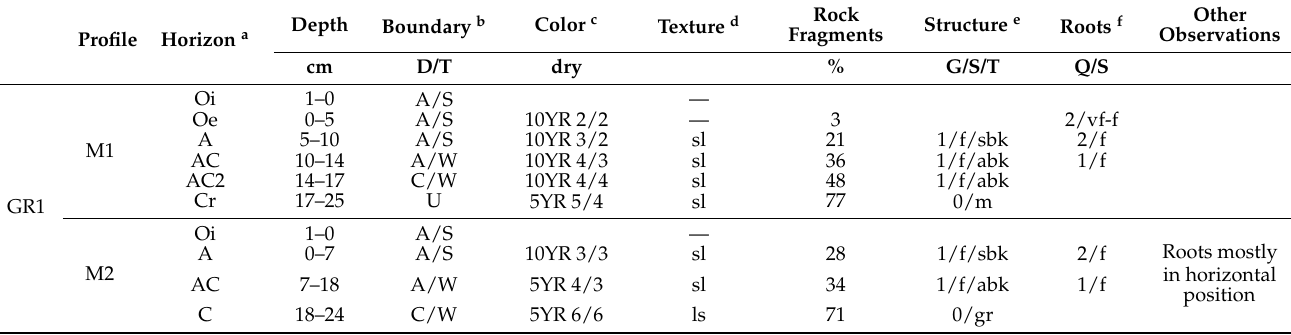
Table 1. General features and morphology of the Technosols within the Baccatoio basin, Pietrasanta, Italy. For symbols see legend